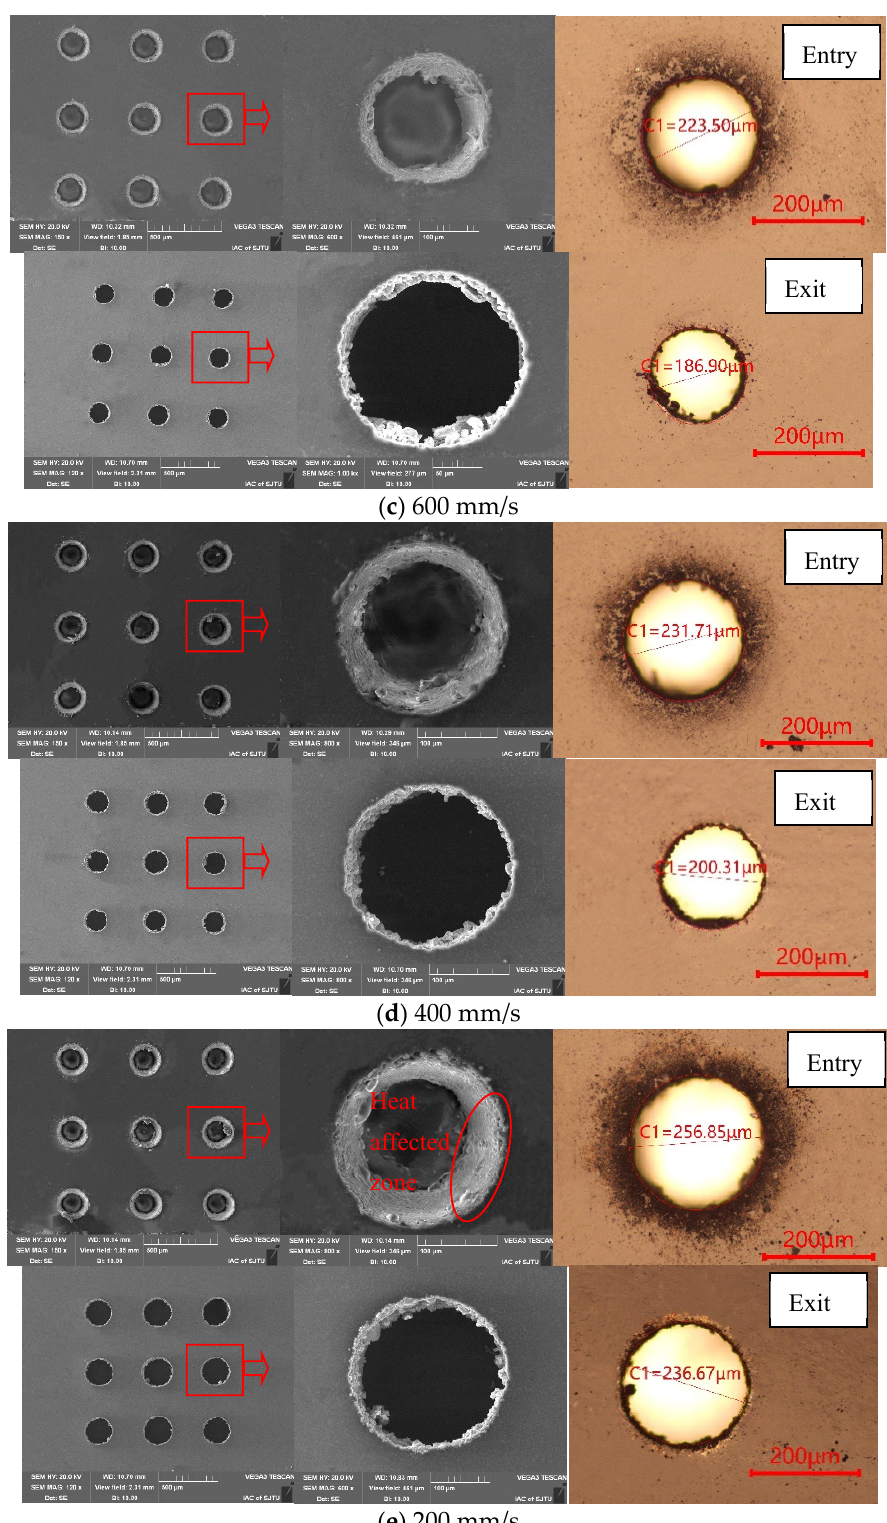
Figure 9. Geometric profiles and SEM images of the microholes generated at different laser scanning speed at the pulse energy of 12 μ J; ( a ) 1000 mm/s; ( b ) 800 mm/s; ( c ) 600 mm/s; ( d ) 400 mm/s; ( e ) 200 mm/s.